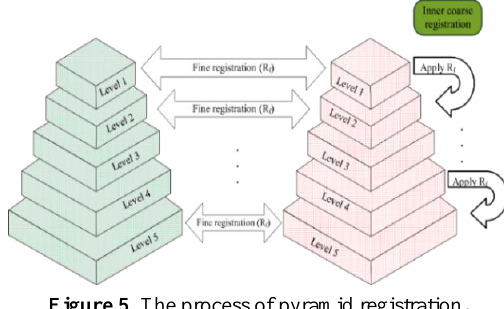
Figure 5. The process of pyramid registration .